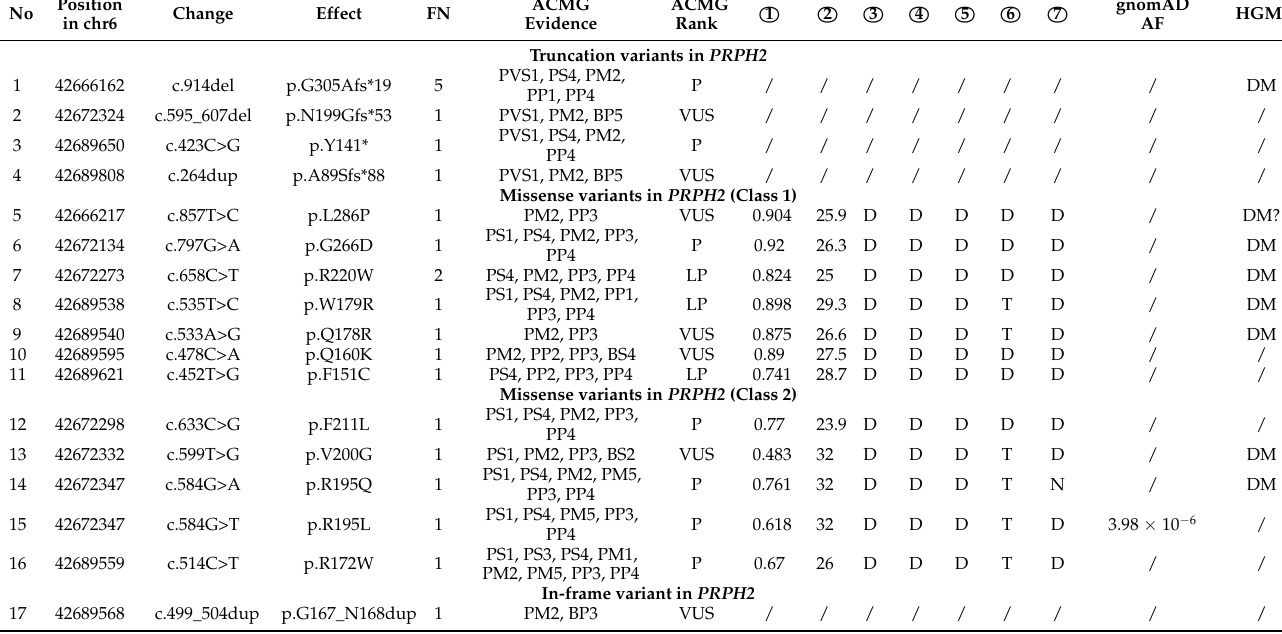
Table 1. Genotypic details of seventeen potential pathogenic variants in PRPH2 identified in our